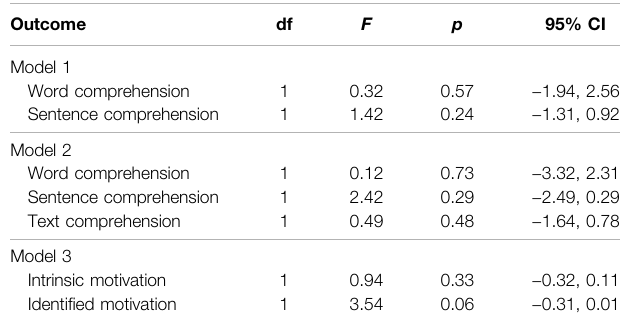
TABLE 4 | Results of Model 1, Model 2, Model